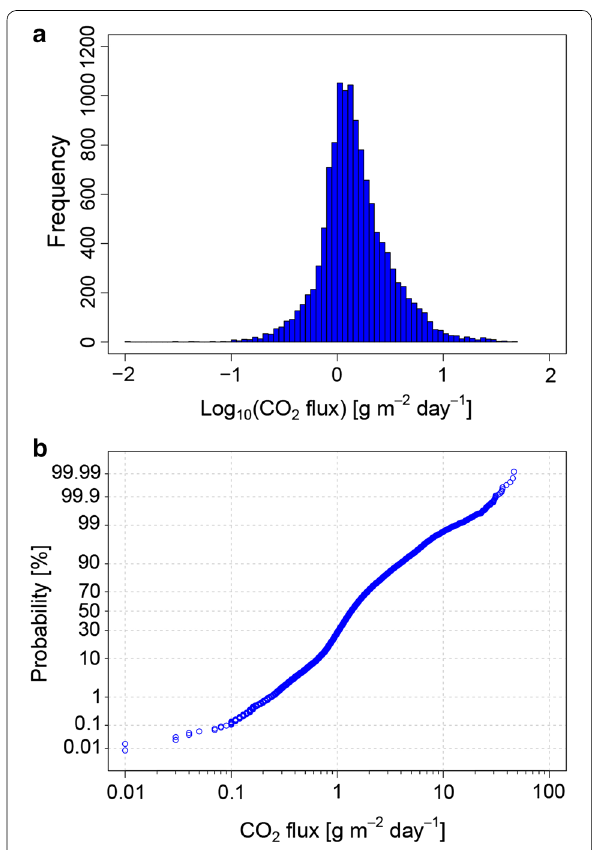
Table 2 Correlation coefficient ( R ) between the daily average of log confidence interval of R ( R ), and t test and p values for R 95 Parameter Degree of freedom R R